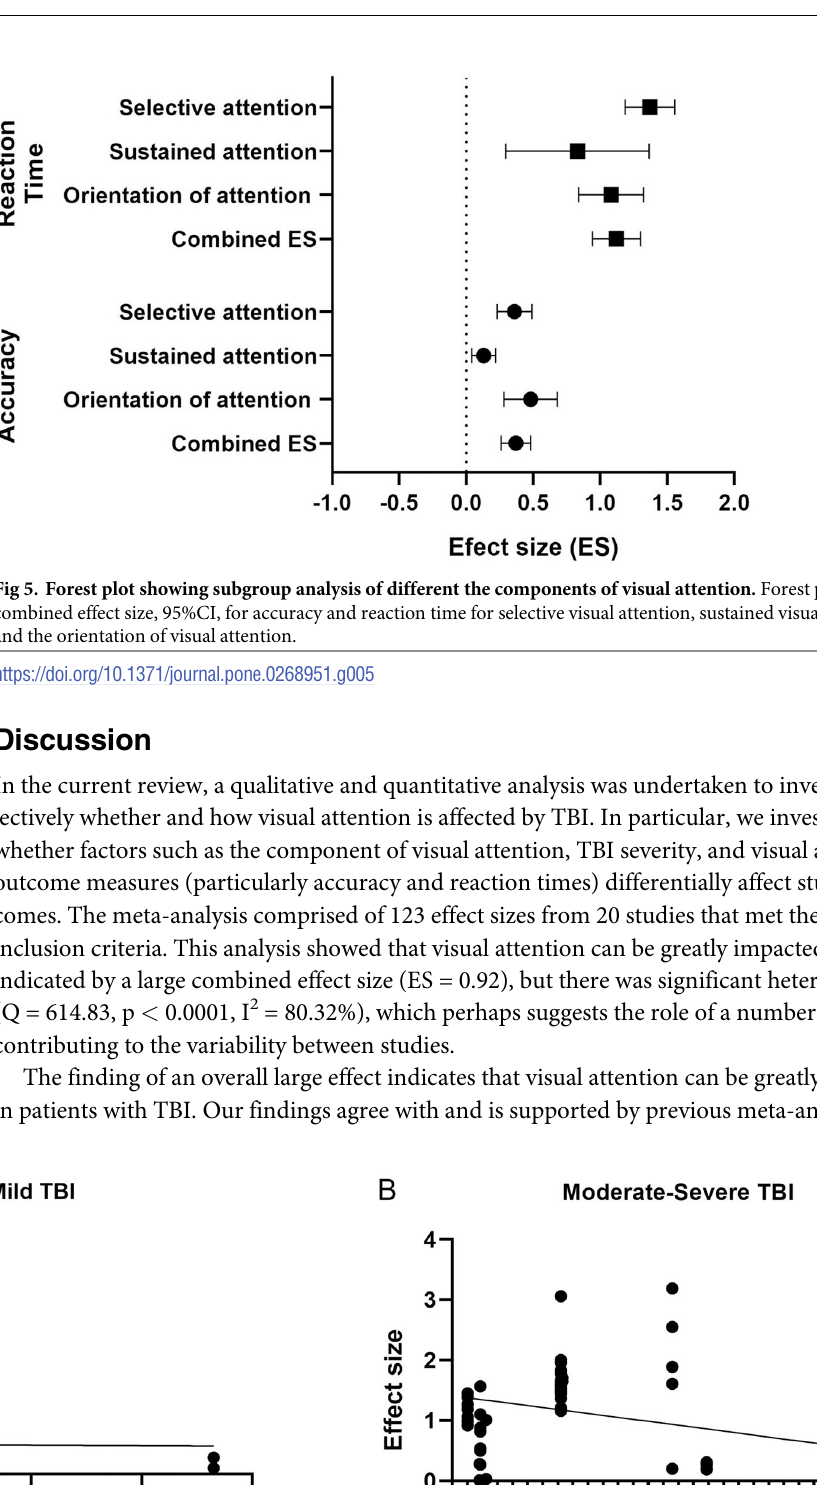
PLOS ONE | https://doi.org/10.1371/journal.pone.0268951 June 9,